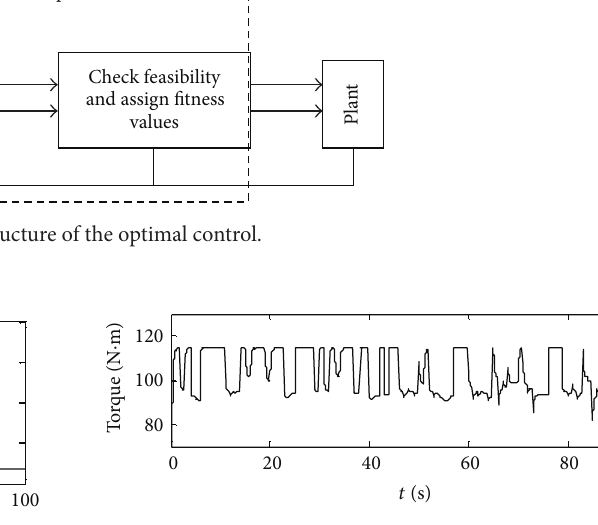
Figure 9: The engine’s real-time torque along 100-second period.